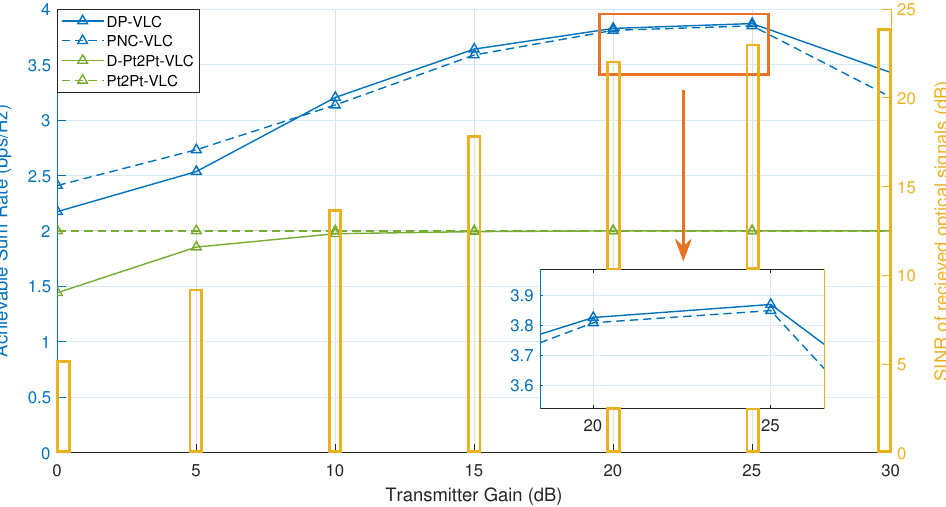
Figure 6. System performance of DP-VLC when k = 2 with comparison of PNC-VLC, D-Pt2Pt-VLC, and Pt2Pt-VLC under different transmitter